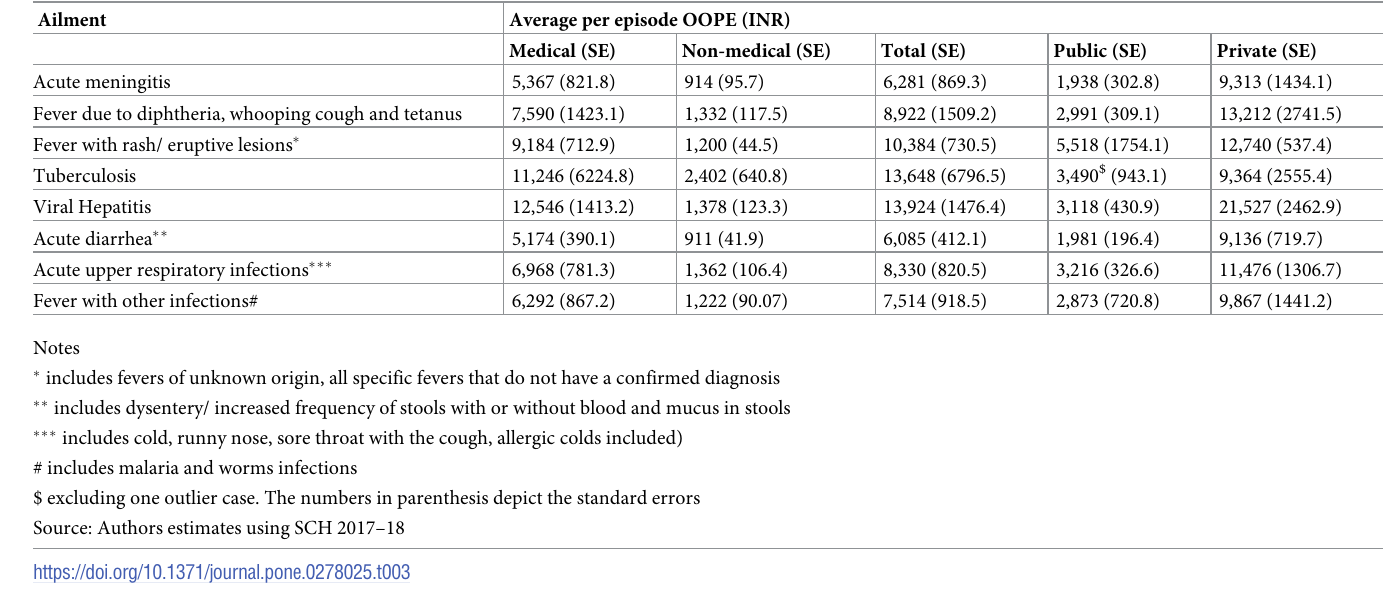
Table 3. Per episode OOPE (INR) on hospitalization for childhood infections,